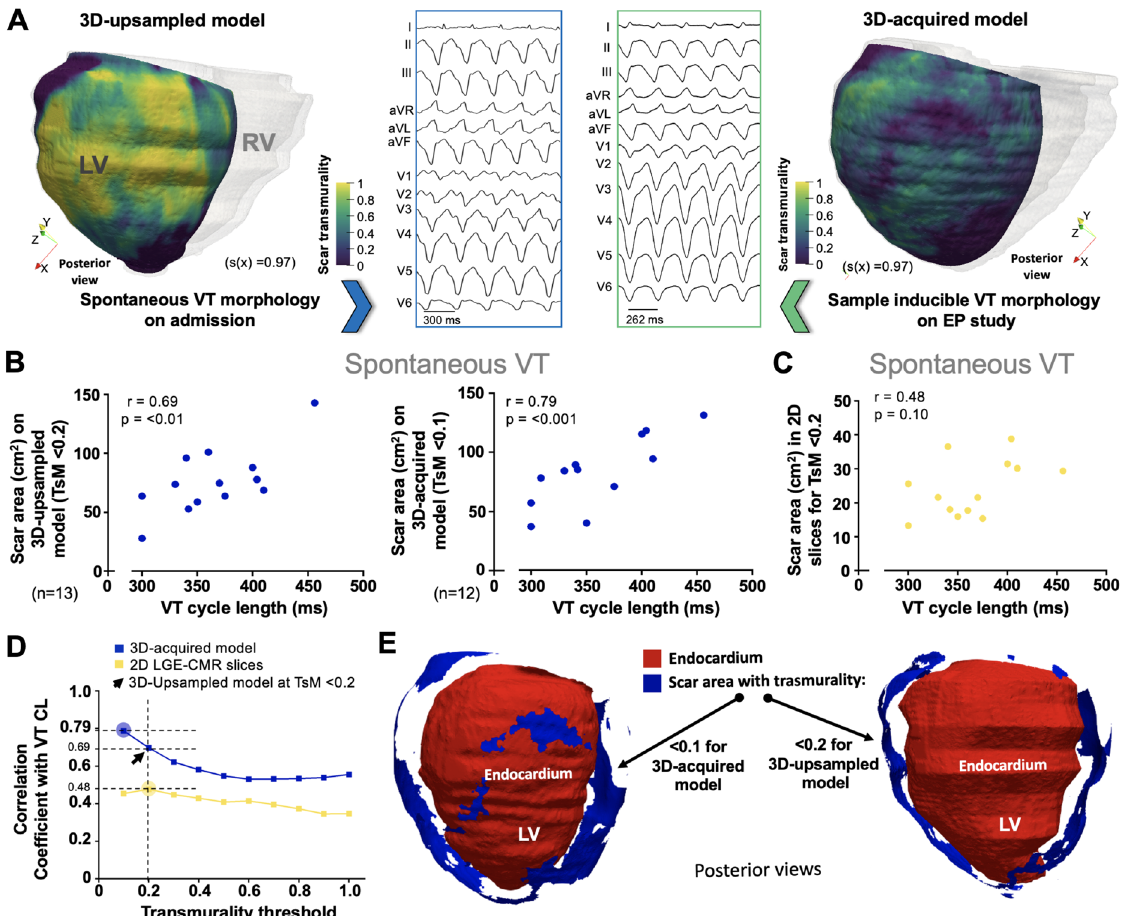
Figure 6. Correlation analysis of transmural scar assessment with the cycle length of ventricular tachycardia episodes. ( A ) Representative 3D-acquired and 3D-upsampled models with transmurality (TsM) maps and the associated ventricular tachycardia (VT) episodes on admission and during the electrophysiological (EP) study. ( B , C ) Correlation analysis between the cycle length (CL) of spontaneous VT episodes and scar areas for wall transmurality < 0.2 (for 3D-upsampled models), < 0.1 (for 3D-acquired models) and < 0.2 [for original 2D LGE-CMR slices, in ( C )]. ( D ) Pearson correlation coefficients between scar assessment at sequential TsM thresholds and the CL of spontaneous VT episodes. ( E ) 3D visualization of scar areas (in blue) using < 0.2 (for 3D-upsampled models) and < 0.1 (for 3D-acquired models) transmurality criteria in the sample case shown in ( A